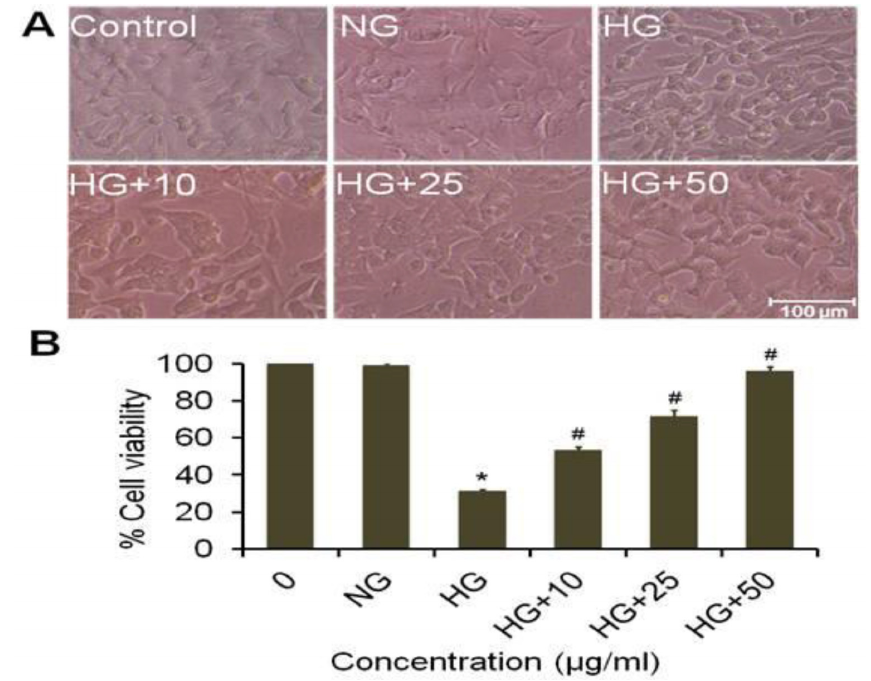
Figure 3. In vitro neuroprotective effects of CMT extract against mammalian neuroblastoma SHSY5Y cells ( A ) Photomicrograph of SHSY5Y cell line treated with NG, HG and 10 to 50 µg/mL concentration of CMT extract ( B ) Dose-response effects of NG, HG and CMT extract at different concentrations on SHSY5Y cell line for 24 h. All values were expressed as Mean ± SEM * p < 0.05, HG vs NG; # p < 0.05, as compared to high glucose.